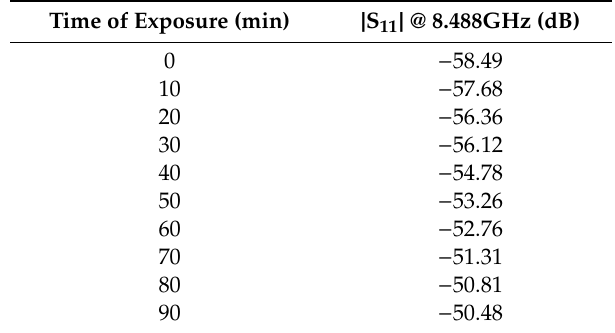
Figure 11. Measured |S 11 | curves of the antenna near to the resonant frequency for different times of exposure. Table 5. Absolute values of S11 of the prototype of the antenna (Figure 9) at the resonant frequency for different times of exposure to PM particles.